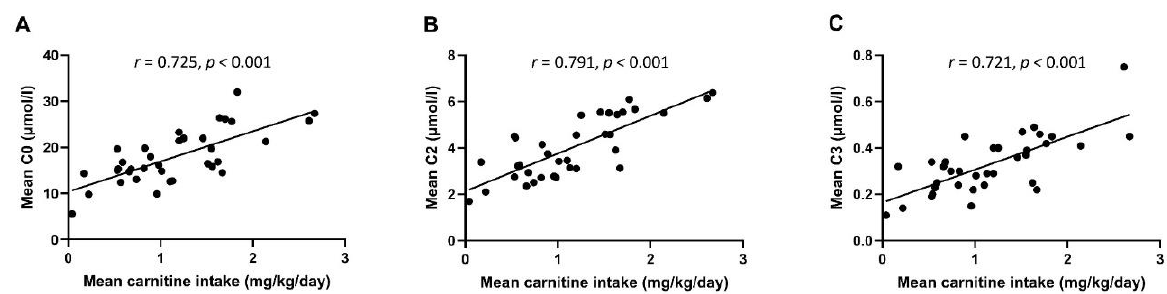
Figure 3. Pearson’s correlations between mean carnitine intake (mg/kg) of weeks 1 and 5 and the mean serum concentrations of free carnitine (C0) ( A ) and short-chain acylcarnitine C2 ( B ) and C3 ( C ) levels at week 1, week 5, and at term-equivalent age.